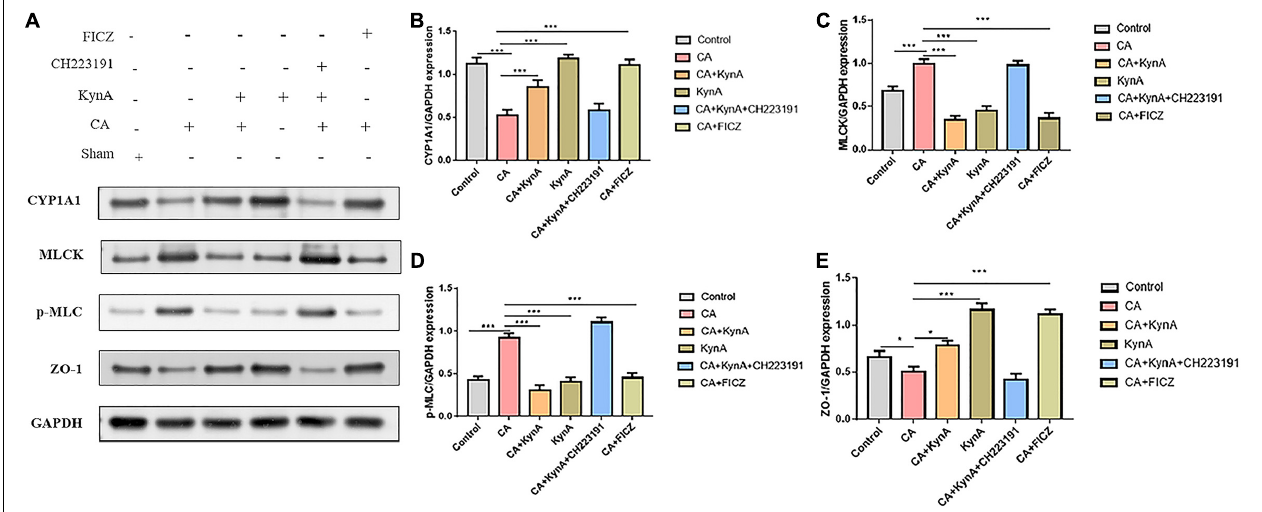
FIGURE 6 | KynA activates the suppression of MLCK-pMLC signaling pathway by AHR. The detection of MLCK expression and MLC phosphorylation was carried out to determine the effect of AHR activation on the MLCK-pMLC signaling pathway. In Caco-2 cells, after KynA treatment, the expression of the AHR downstream protein CYP1A1 increased significantly, as did the expression of the tight junction proteins ZO-1 and occludin. The expression of MLCK and pMLC decreased significantly. In the CA-Caco-2 cell model, expression levels of CYP1A1, ZO-1, and occludin were significantly decreased, but the expression levels of MLCK and pMLC increased. After treatment with KynA and the AHR agonist FICZ, expression of CYP1A1 increased significantly, as did the expression of ZO-1 and occludin, but the expression of MLCK and pMLC decreased. Treatment with an AHR inhibitor (CH223191), led to a decrease in the expression of CYP1A1, ZO-1, and occludin, and to an increase in the expression of MLCK and pMLC. Statistical significance was evaluated using the Mann–Whitney U test. P -values < 0.05 (*) or < 0.001 (***) were considered statistically significant. CA, Candida albicans infection; KynA, Kynurenic acid; FICZ,